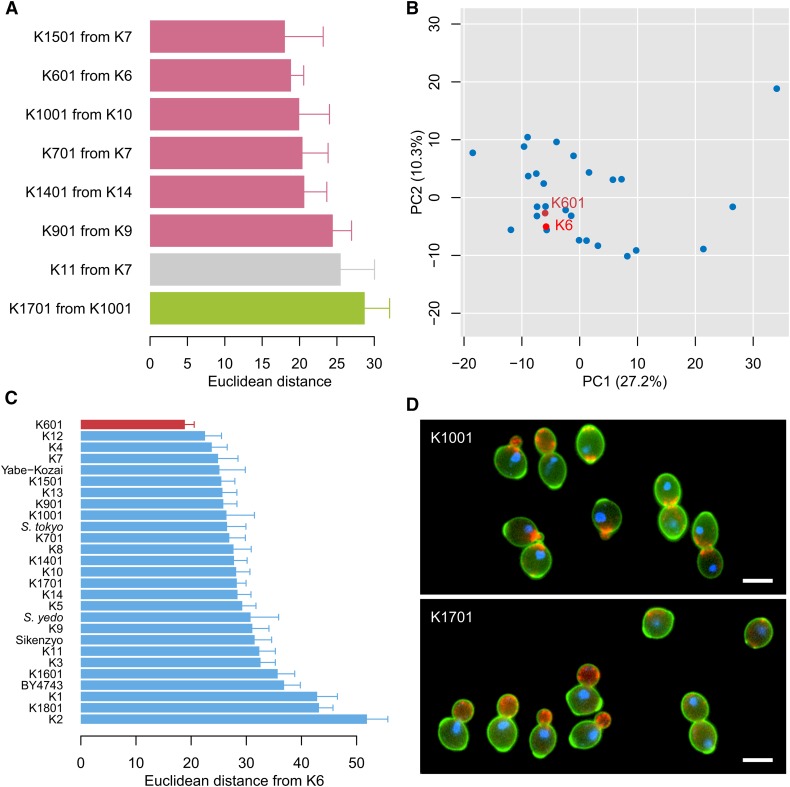
Morphological differentiation upon mutation breeding. (A) Distribution of Euclidean distance from parent strain. The Euclidean distance was calculated from PC scores of 16 PCs (CCR = 90%). The green bar indicates a sake yeast strain isolated with mutagen. Pink bars indicate nonfoam-forming sake yeast. Error bars indicate SD. (B) Distribution of phenotypes between parent strain and its progeny. Red circles indicate the parent strain (K6: bright red) and its progeny (K601: dark red). (C) Distribution of Euclidean distance from K6. The Euclidean distance was calculated from PC scores of 16 PCs (CCR = 90%).The color legends are the same as in (B). Error bars indicate SD. (D) Photographs of K1001 and K1701 strains. Green, red, and blue represent cell shape, actin, and nuclear DNA, respectively. Bar, 5 μm.